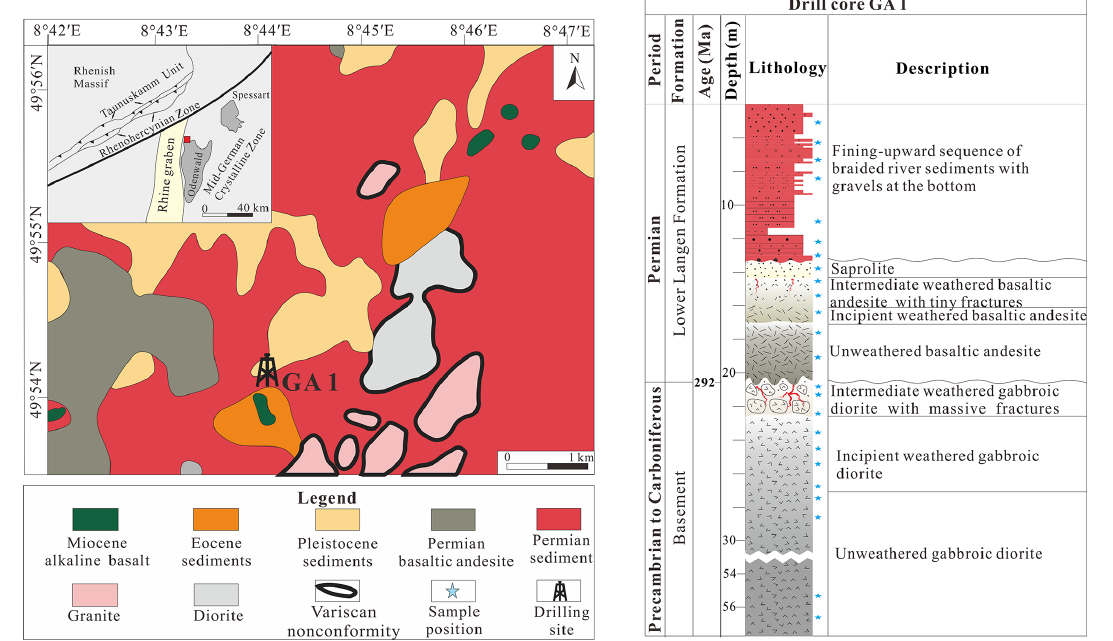
Figure 1. Location and geology of the research area, and the lithological section of the GA1 drill core; note the gap between 30 and 54m drilling depth. Blue stars indicate the sampling